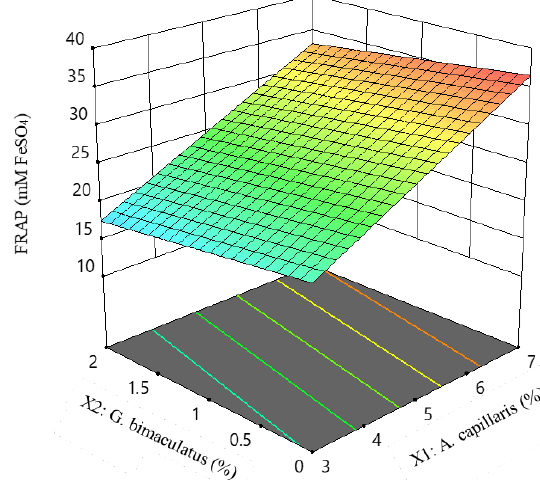
Figure 5. Response surface and contour plots for FRAP value of MKJW-fermented A. capillaris .